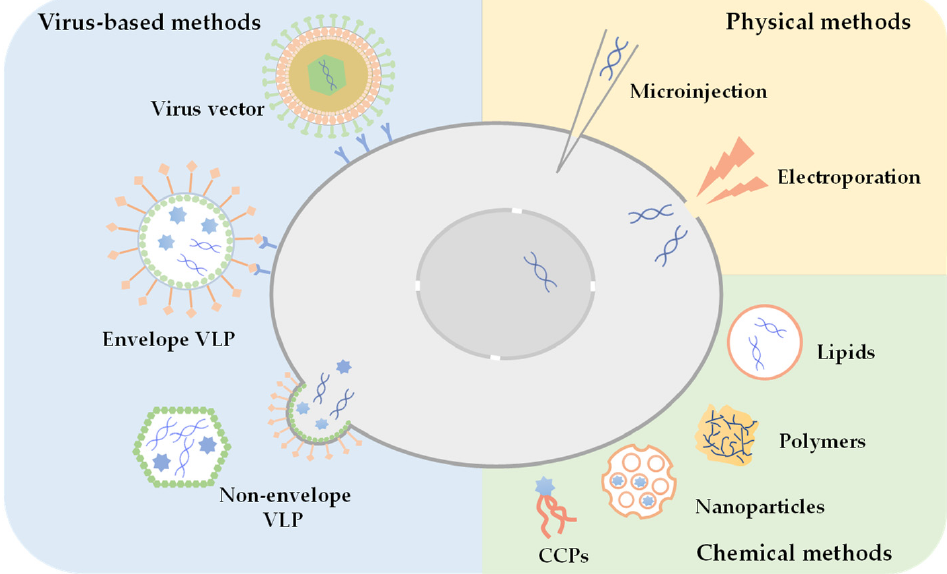
Figure 1. Methods for intracellular delivery. Physical methods such as electroporation and microinjection, chemical methods such as liposome, nanoparticles, etc., and virus-based methods like infectious viral vectors and VLPs, are the major categories of intracellular delivery methods.